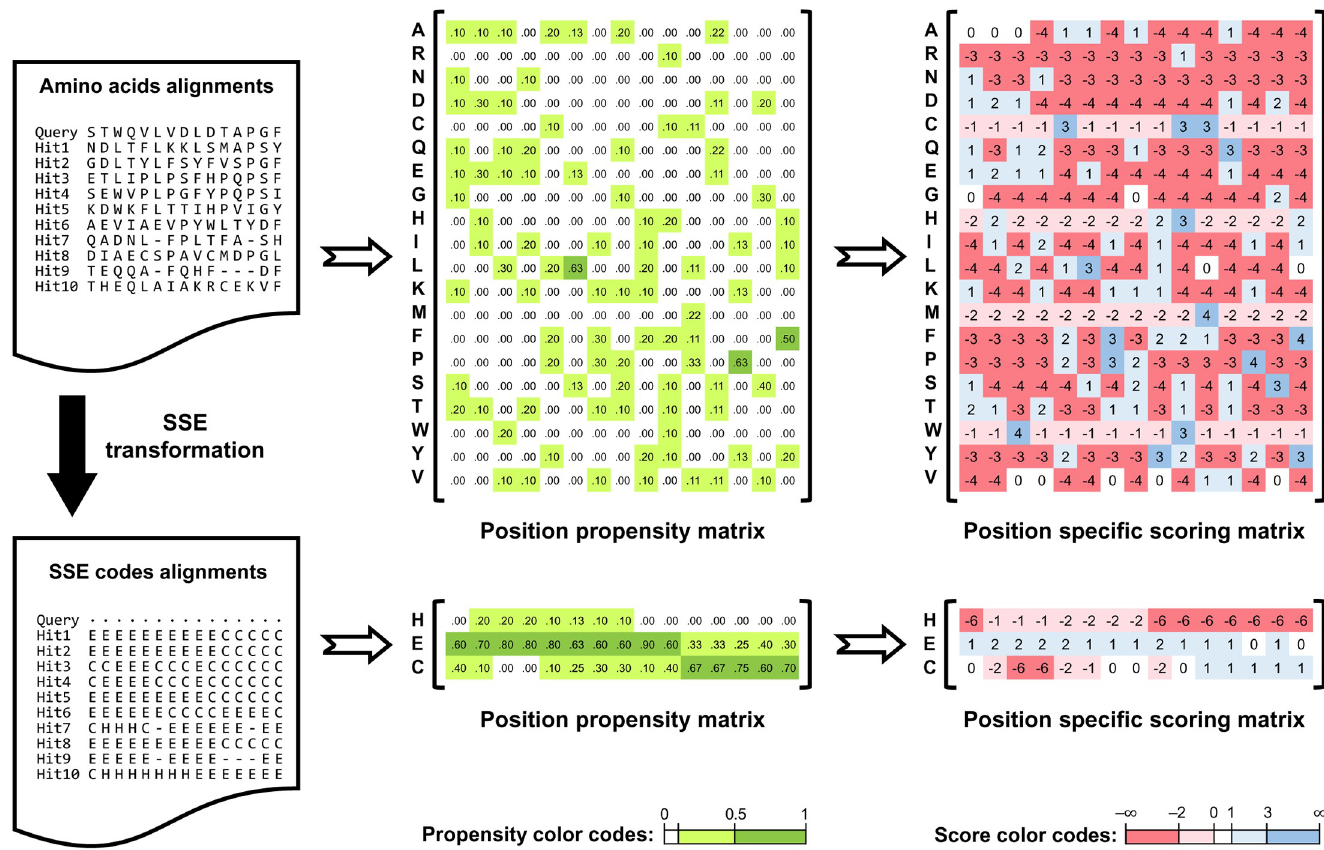
Fig 1. Position-specific scoring matrix of amino acids vs . secondary structure